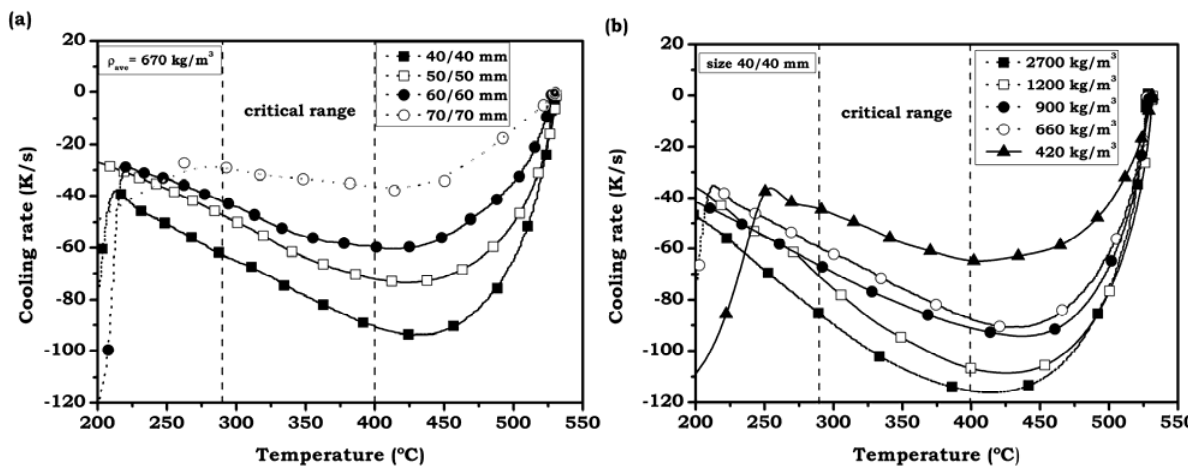
Figure 7. Quenching curves obtained for foam samples: ( a ) Effect of sample size ( ρ = 650 kg/m 3 ). ( b ) Effect of density (size 40/40 mm).